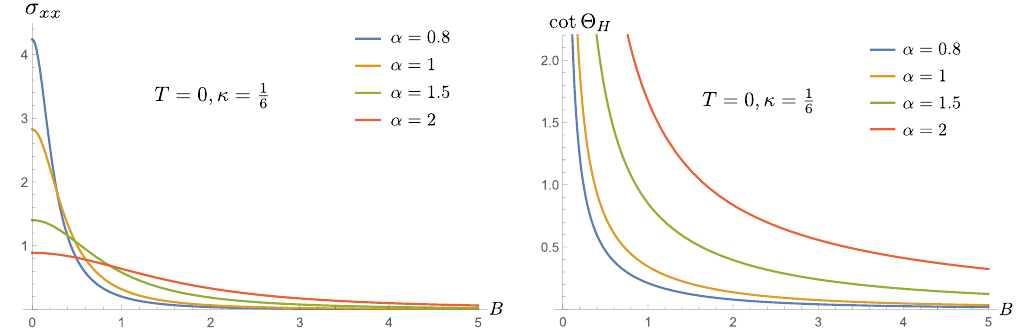
Figure 4 . Magnetotransport for the Exponential model as a function of magnetic (cid:12)eld. Both the longitudinal conductivity (cid:27) xx (left) and the inverse Hall angle cot (cid:2) H = (cid:27) xx =(cid:27) xy (right) decrease monotonically as B is increased. We have (cid:12)xed T = 0 and (cid:26) = 1.